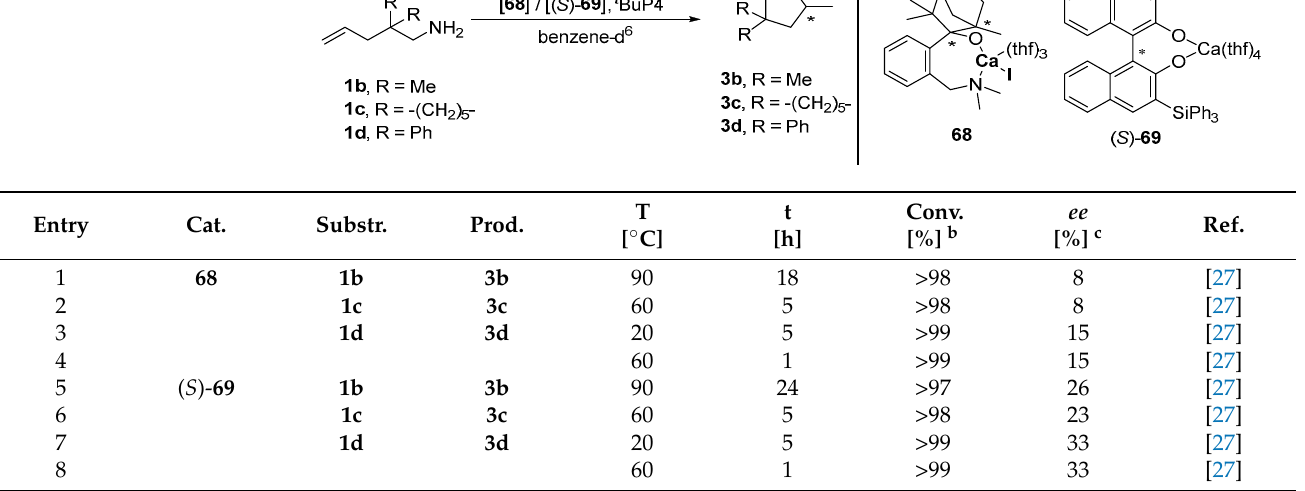
Figure 4. Catalytic cycle of the intramolecular hydroamination of aminoalkenes using CaI 2 as cat- alyst and t Bu P4 as external base